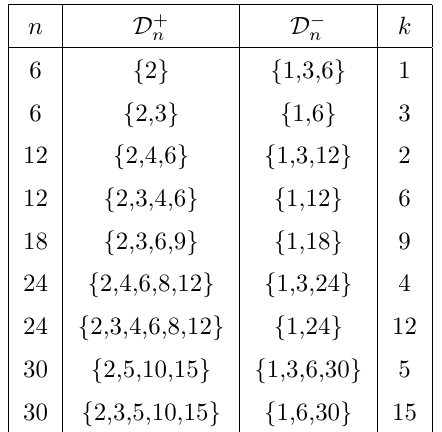
( y ) from (3.16). The third column n